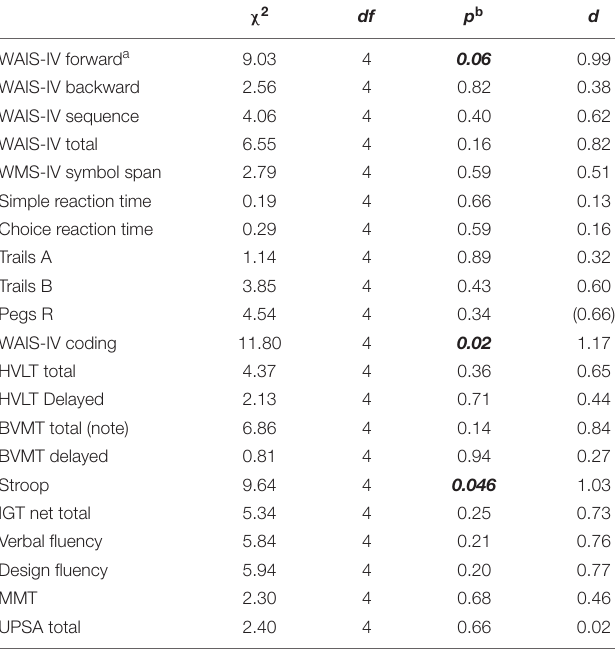
TABLE 3 | Likelihood ratio test and effect sizes for the interaction of group by